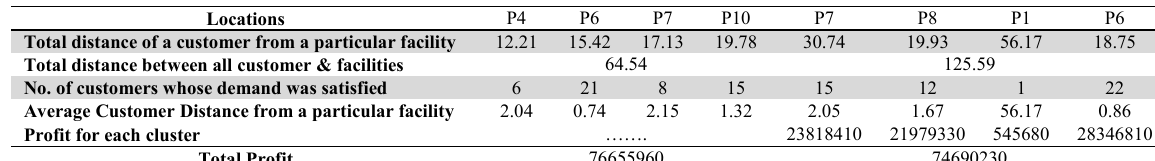
Number of clusters =